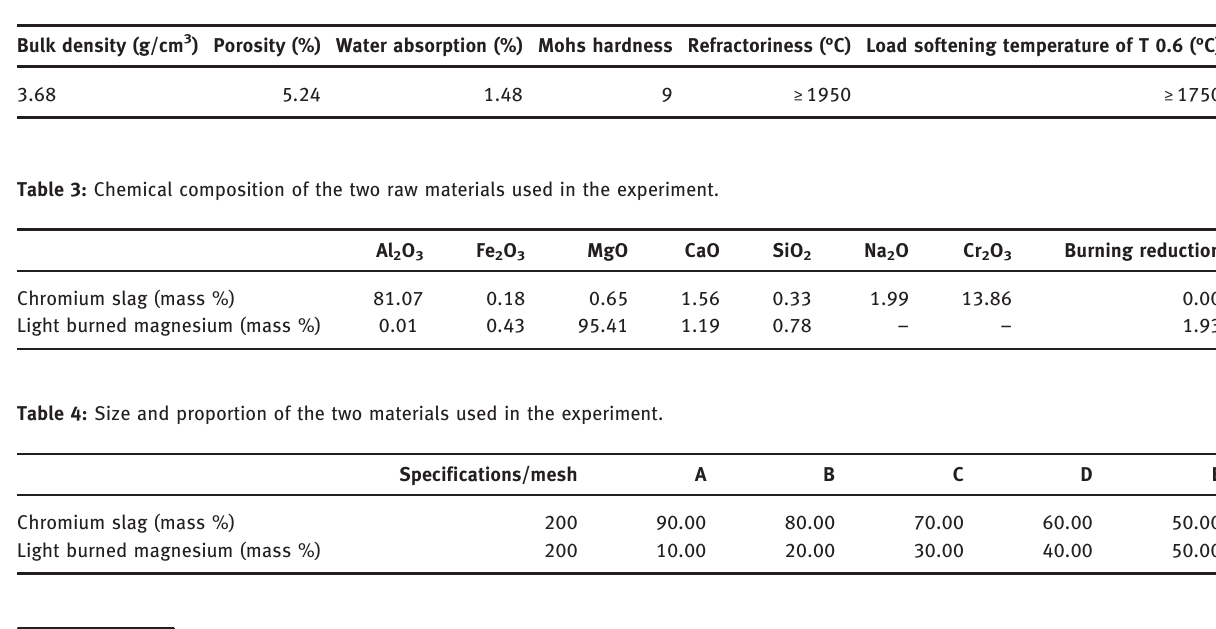
Table 2: The physical properties of chromium slag.